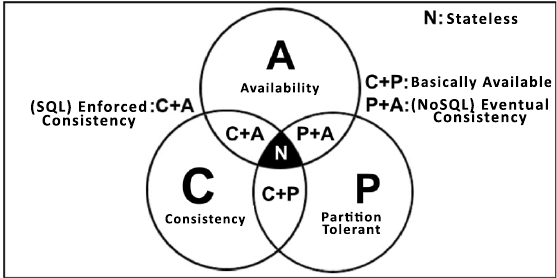
Figure 1. Brewer’s Theorem—Based on